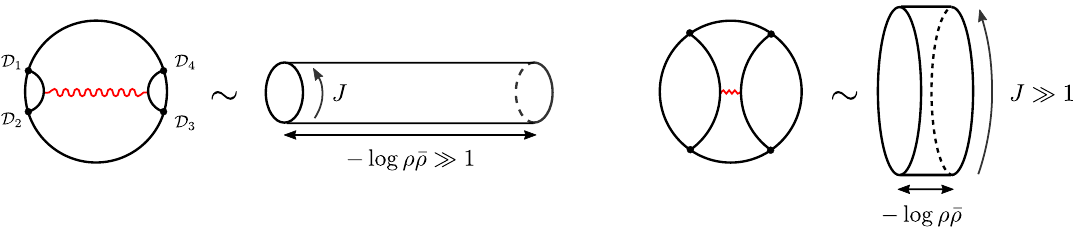
Figure 37 . The cylinder partition function in two di(cid:11)erent limits. When (cid:26) (cid:22) (cid:26) is small (as in the left (cid:12)gure), we can study the four-point function by applying the TBA in the mirror channel. This is nothing but the OPE limit and is precisely what is done in this paper. On the other hand, when (cid:26) (cid:22) (cid:26) is large (as in the right (cid:12)gure), the behavior of the four-point function can be studied by applying the TBA in the physical